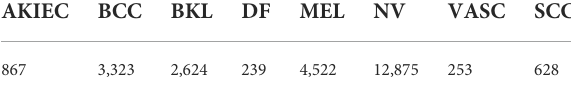
TABLE 1 ISIC 2019